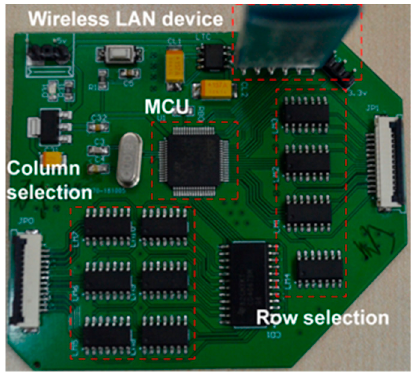
Figure 3. PCB board of the sensor array scanning circuit.